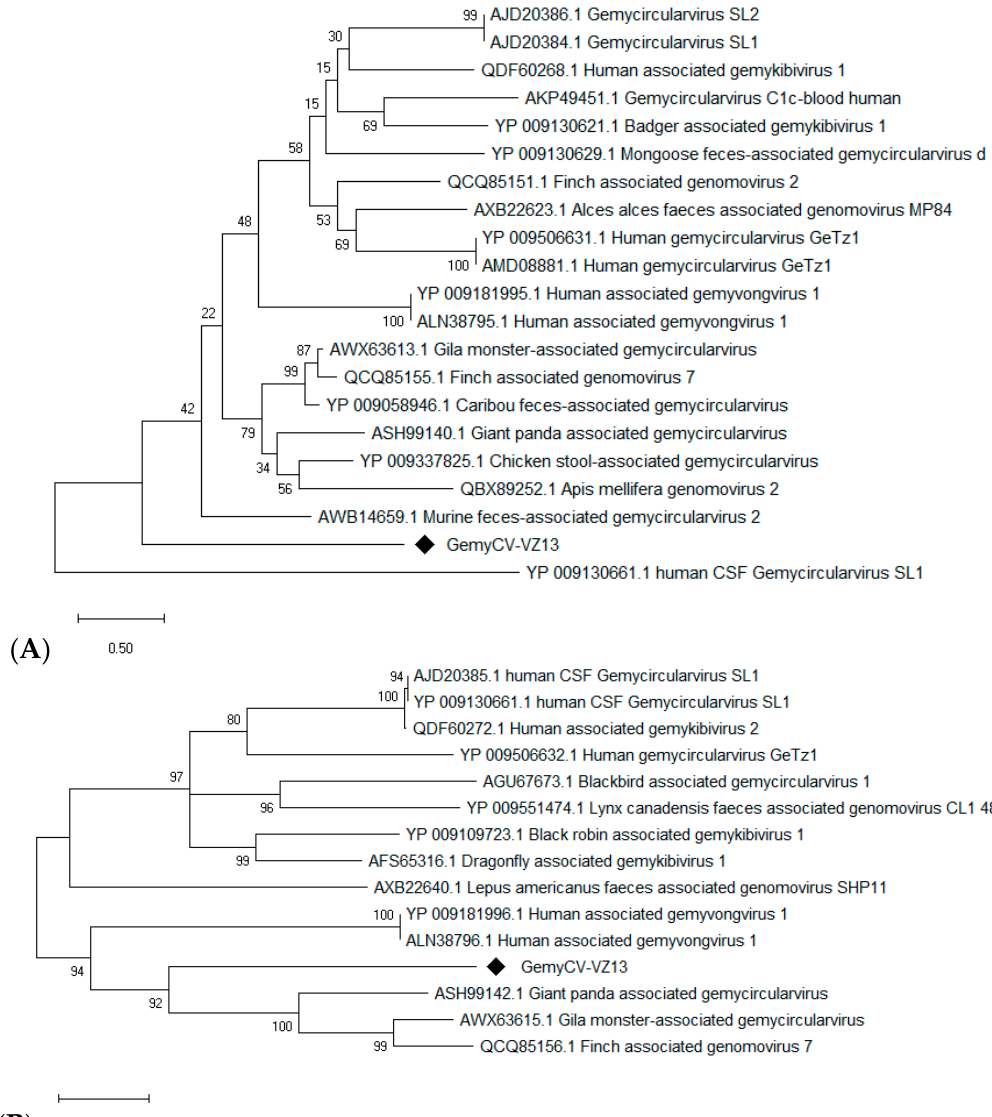
Figure 3. Phylogenetic tree of capsid ( A ) and replication ( B ) proteins of the gemycircularvirus VIZIONS-2013 (GemyCV-VZ13) compared to the viruses of the Genomoviridae family.